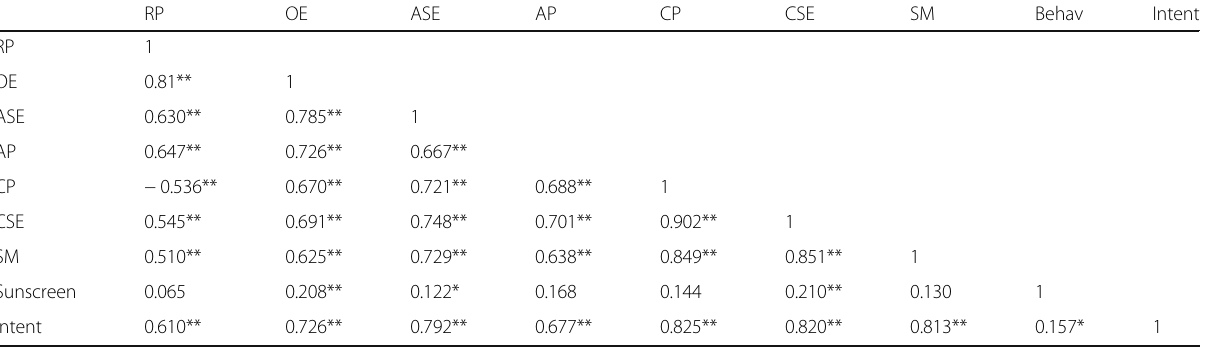
Table 3 Correlations between RP, OE, ASE, CSE, AP, CP, and SM; intention; and behavior